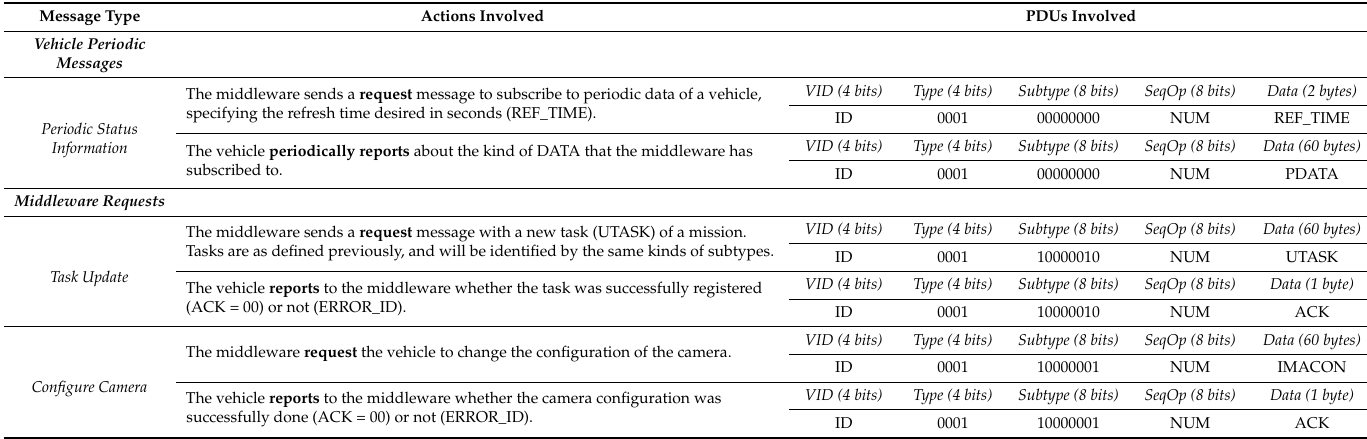
Table 5. Serialized data for underwater